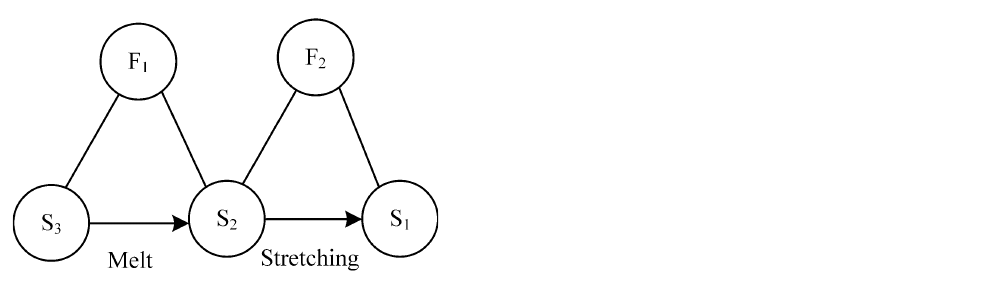
Figure 4. Material-field model of